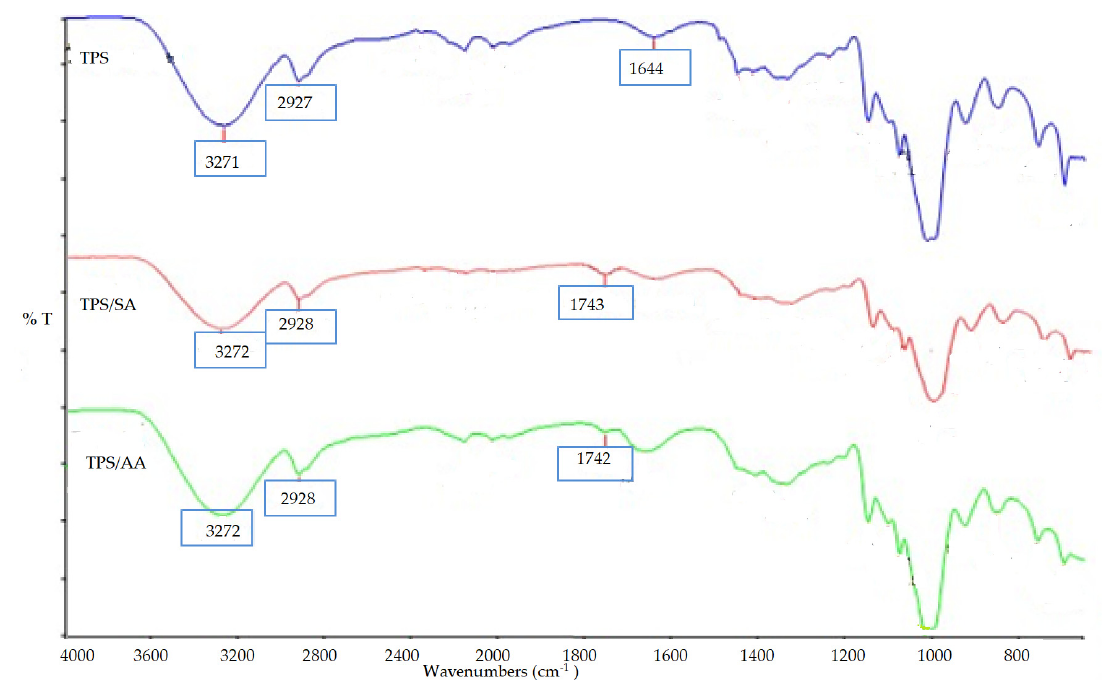
Figure 7. FTIR spectra of untreated TPS and TPS treated with SA and AA.